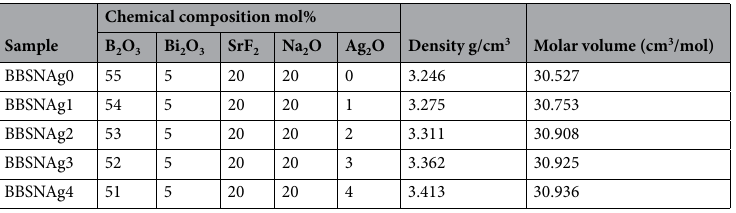
Table 1. The chemical composition,density and molar volume of the fabricated BBSNAg glass samples.